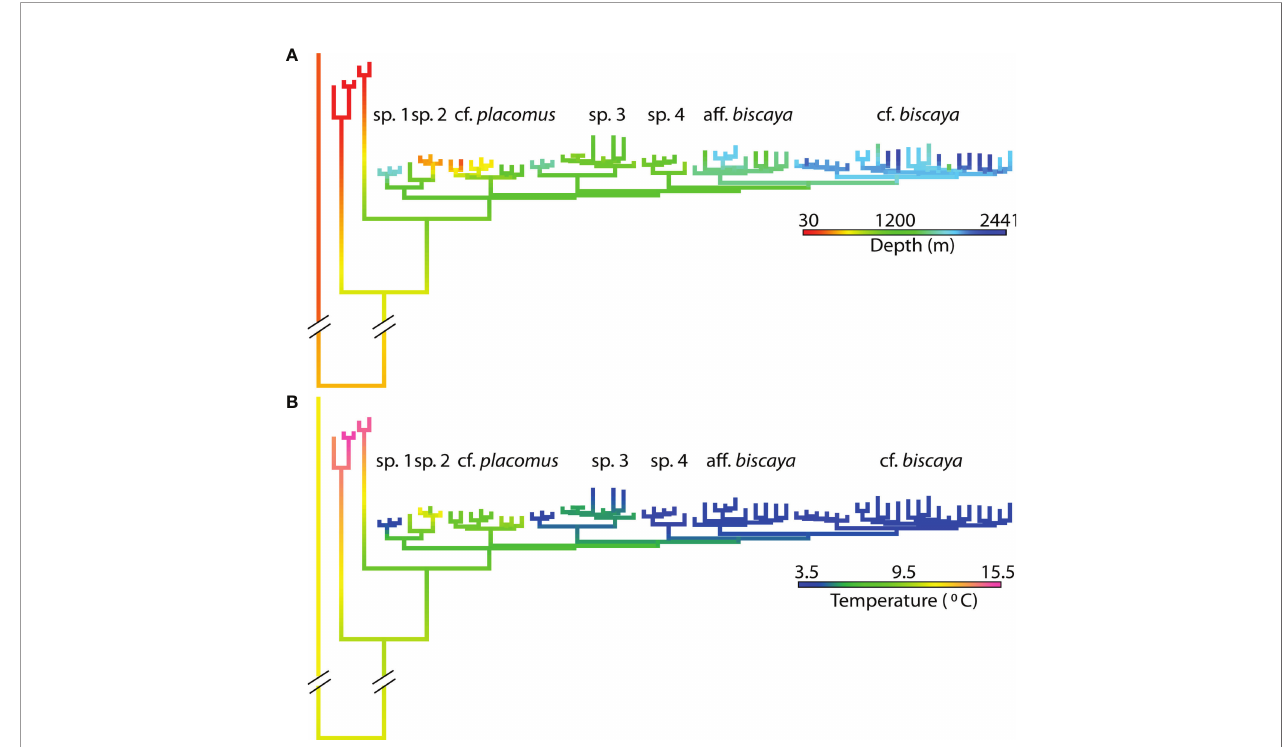
FIGURE 4 | Ancestral state reconstructions of (A) depth and (B) temperature on the phylogeny from Figure 2